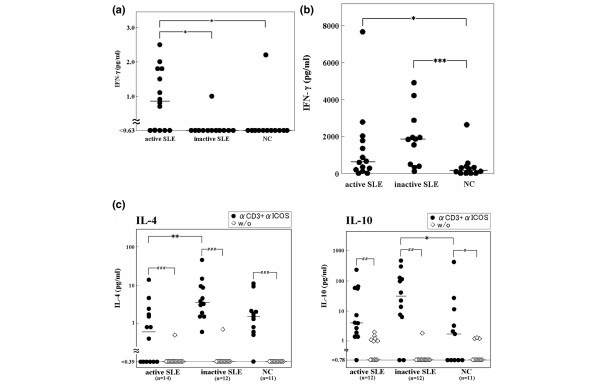
Cytokine production by peripheral blood T cells from SLE patients after ICOS co-stimulation. Peripheral blood T cells were isolated from patients with active SLE (n = 14), patients with inactive SLE (n = 12) and normal control individuals (n = 12) and cultured with or without ICOS co-stimulation for 72 hours; the culture supernatants were collected and the production of IFN-γ, IL-4 and IL-10 were determined by ELISA. (a) Production of IFN-γ without stimulation. (b) Production of IFN-γ with ICOS co-stimulation. (c) The production of IL-4 and IL-10 with or without ICOS co-stimulation. *P < 0.05, **P < 0.01, ***P < 0.005 by Mann-Whitney U-test. #P < 0.05, ##P < 0.01, ###P < 0.005 by Wilcoxon rank sum test. ICOS, inducible co-stimulator; NC, normal control; SLE, systemic lupus erythematosus.